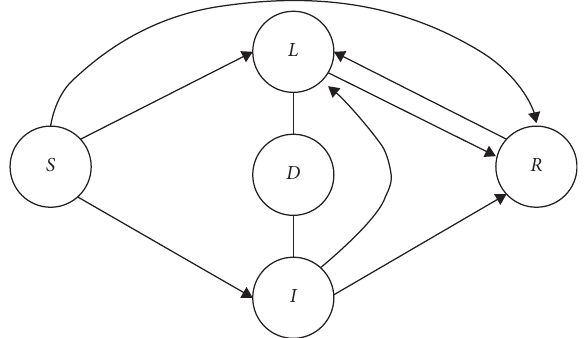
Figure 2: The flow diagram of the propagation model. The letters in the circle represent the corresponding state of the node. Arrows indicate the direction of transition between node